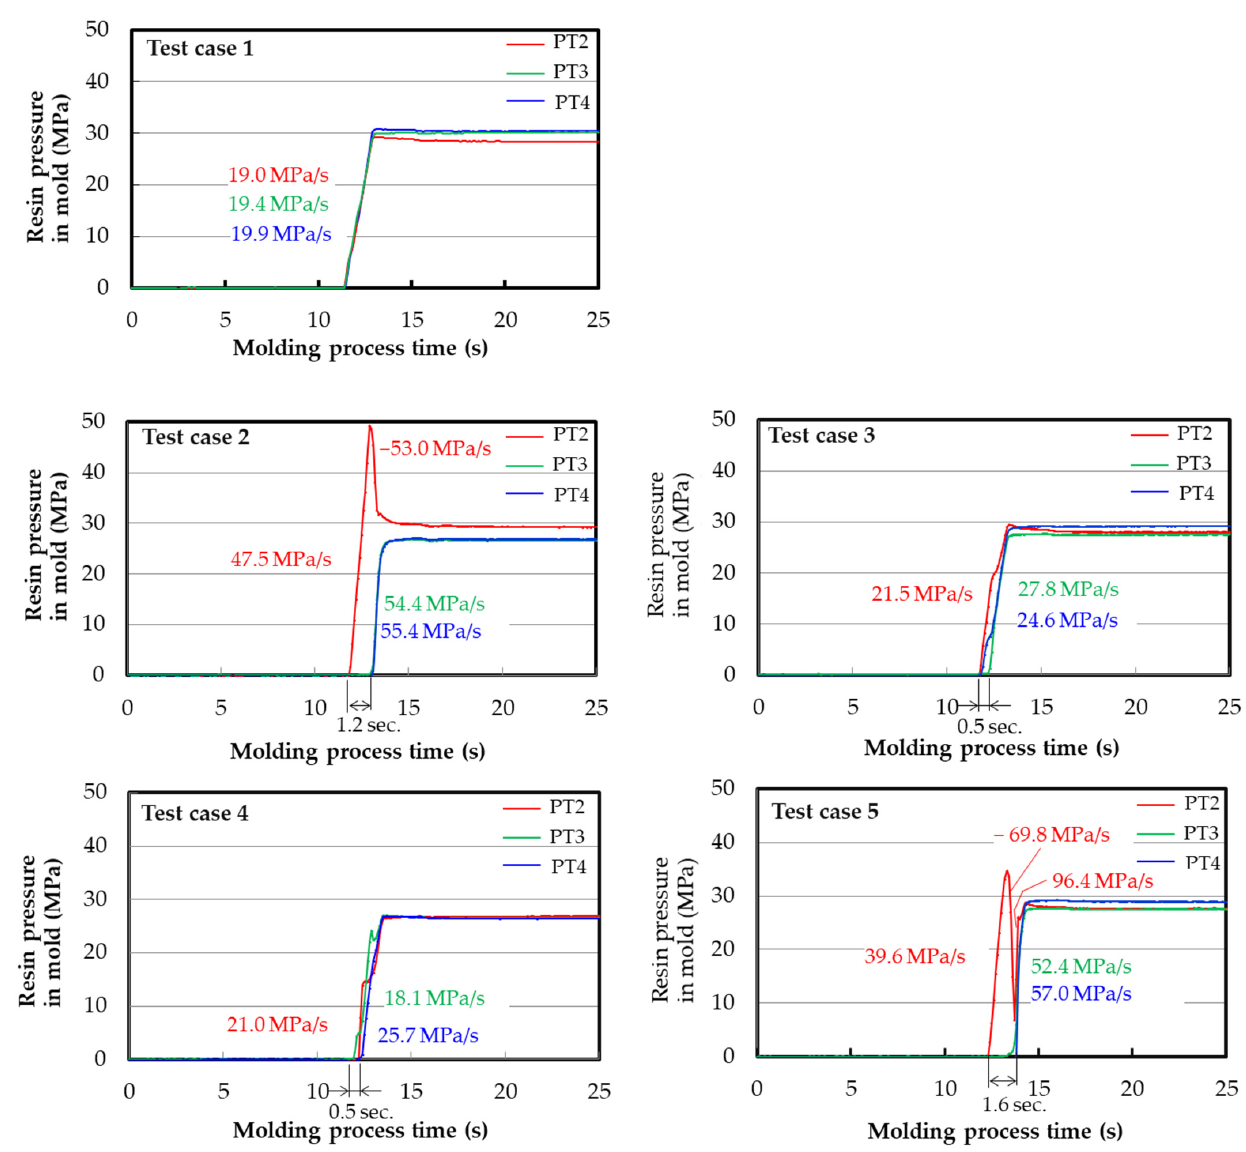
Figure 9. Time changes of resin pressures in the molds when each test case was conducted. ([Pressure increase and decrease rate] red: PT2, green: PT3, blue: PT4).